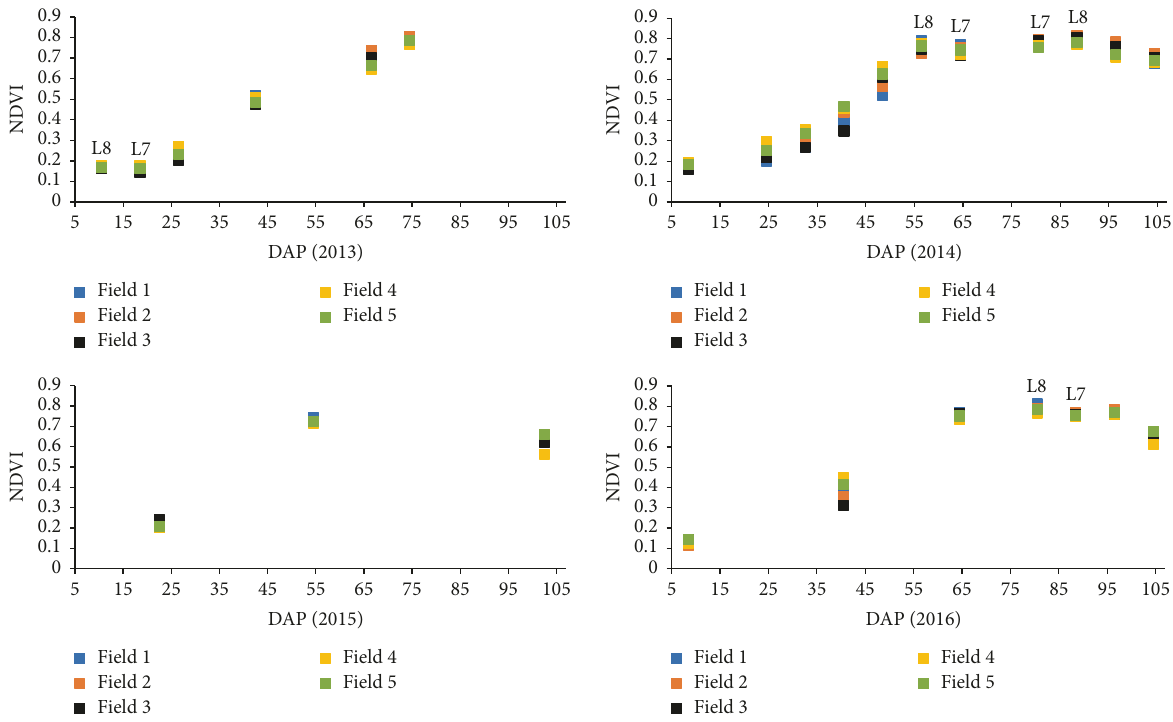
NDVI curves of forage corn gradually increased from initial to mid-season and then remained constant until the end of the